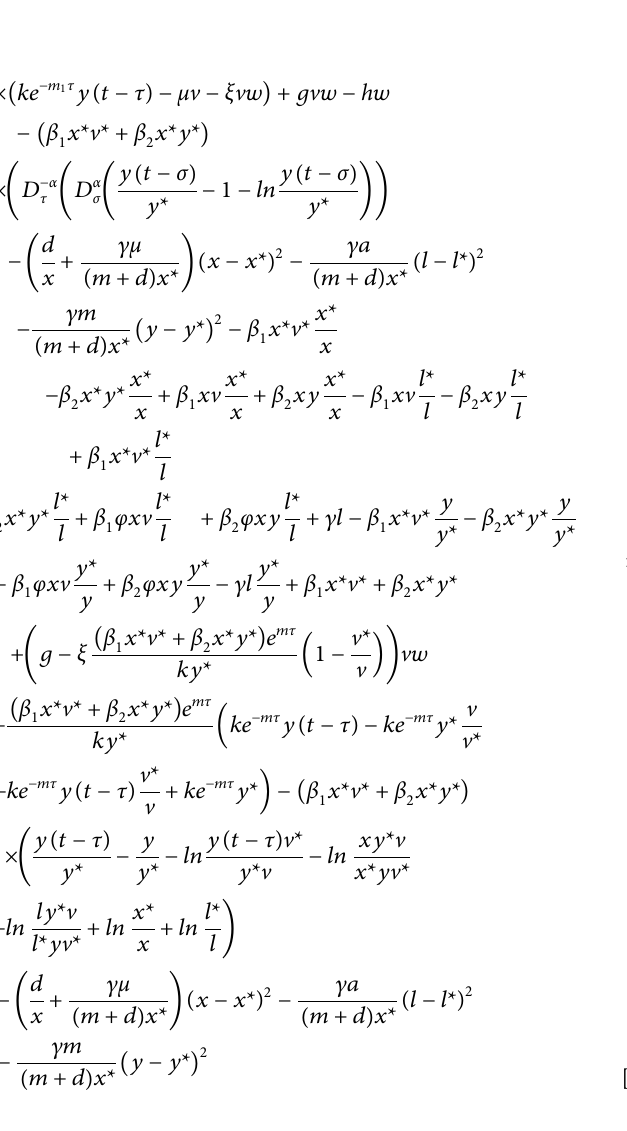
Frontiers in Applied Mathematics and Statistics |